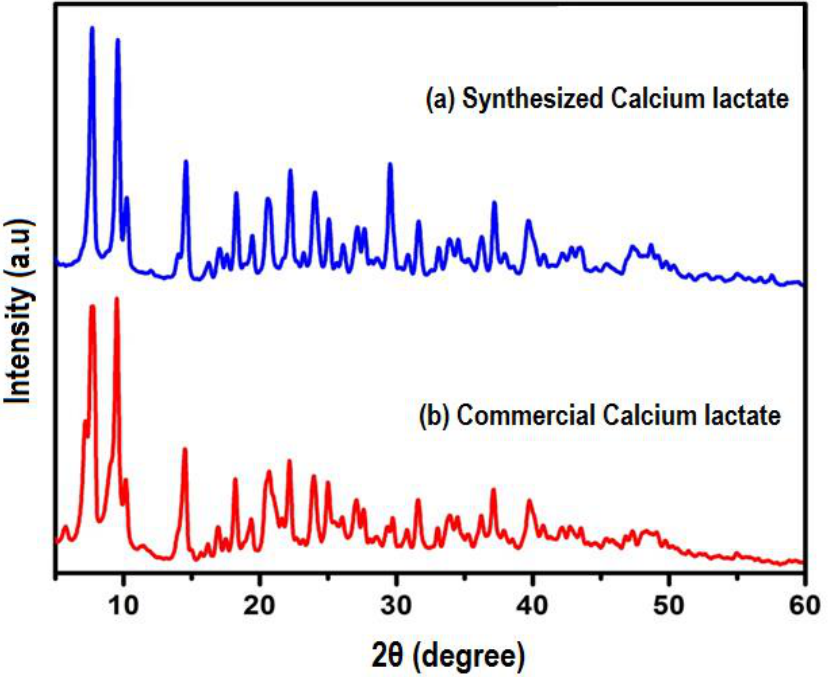
Figure 2. XRD pattern: ( a ) synthesized and ( b ) commercial (reference) calcium lactate powders.